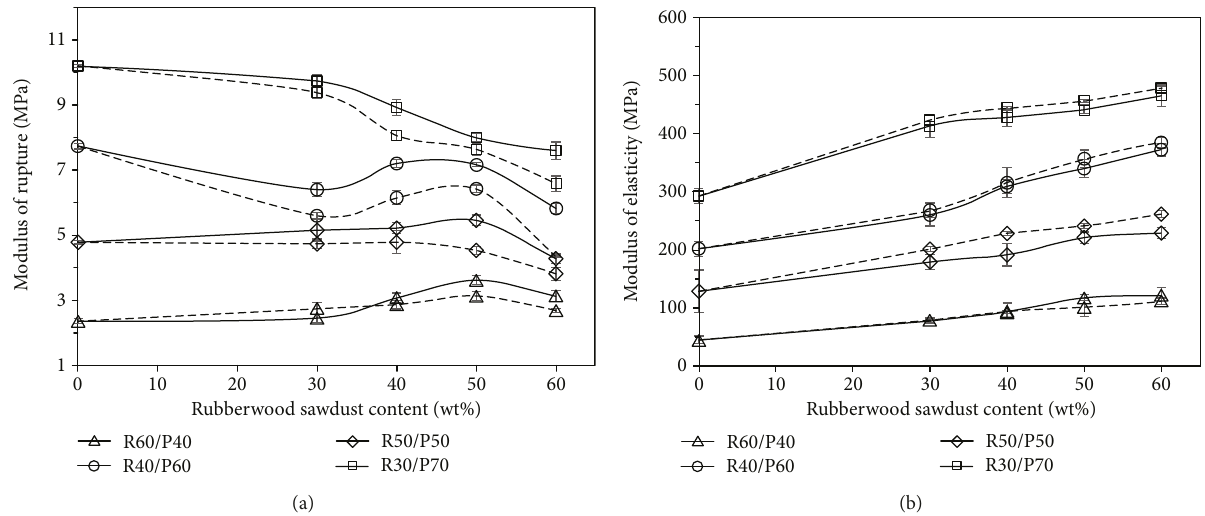
Figure 7: E ff ect of wood sawdust contents and sizes on (a) modulus of rupture and (b) modulus of elasticity for TPNR/RWS composites. Dashed lines show RWS 40 mesh, and solid lines represent RWS 80 mesh. TPNR composites based on RWS 80 mesh (solid lines) exhib- ited lower values.